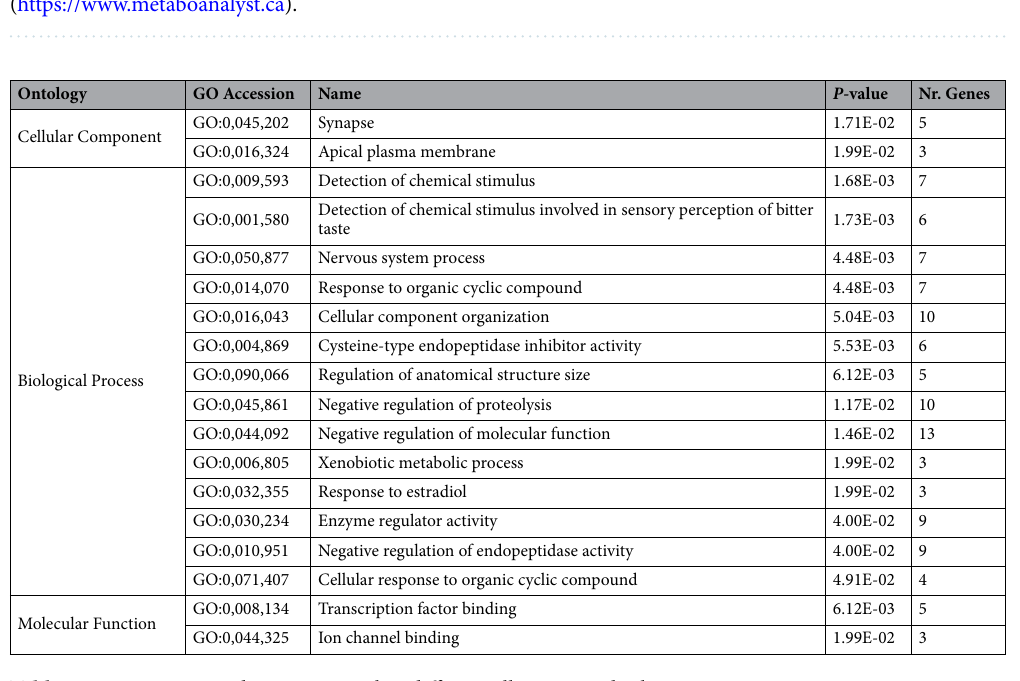
Table 1. Overrepresented GO terms within differentially expressed saliva proteins in COVID-19 patients.